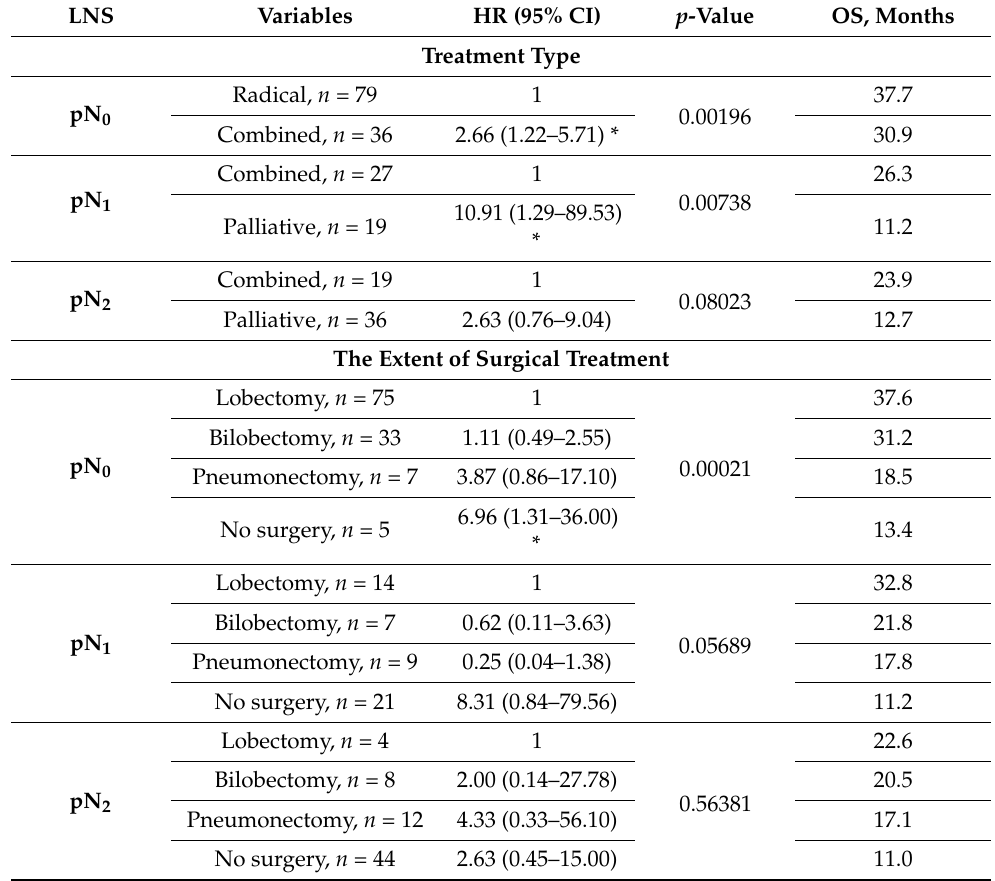
Table 2. Overall survival rates depending on the type of treatment and the volume of